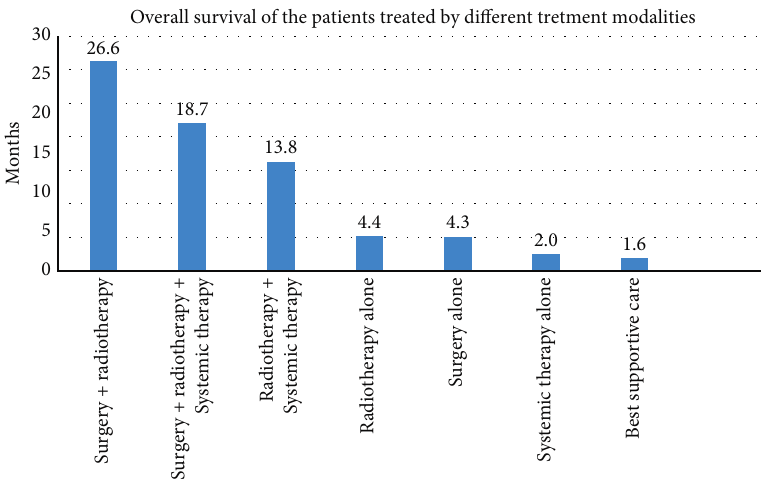
Figure 5: Overall survival of the patients treated by different treatment